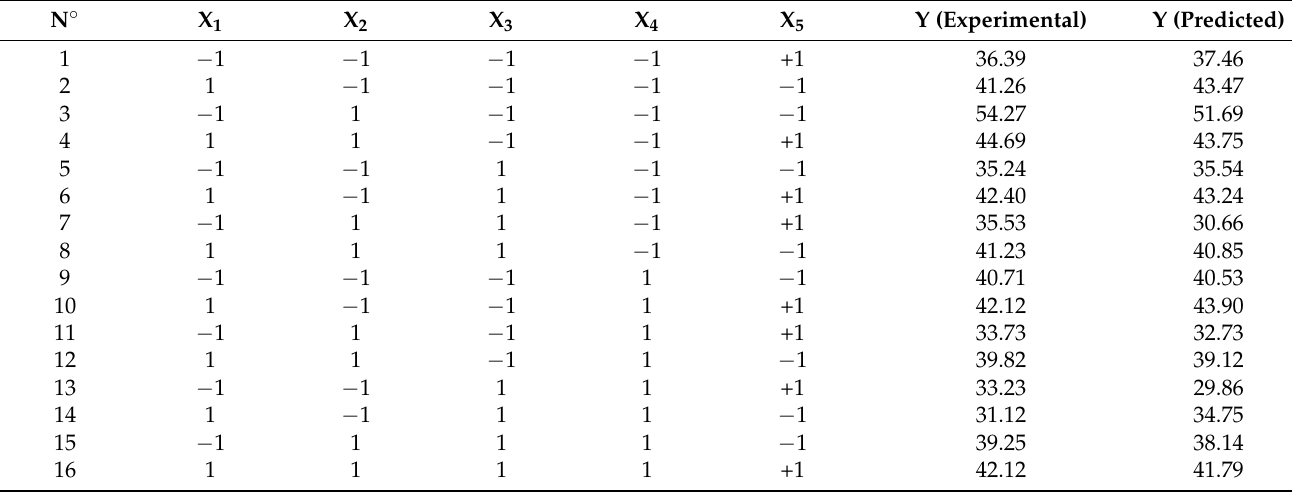
Table 2. Matrix design with experimental and predicted COD removal